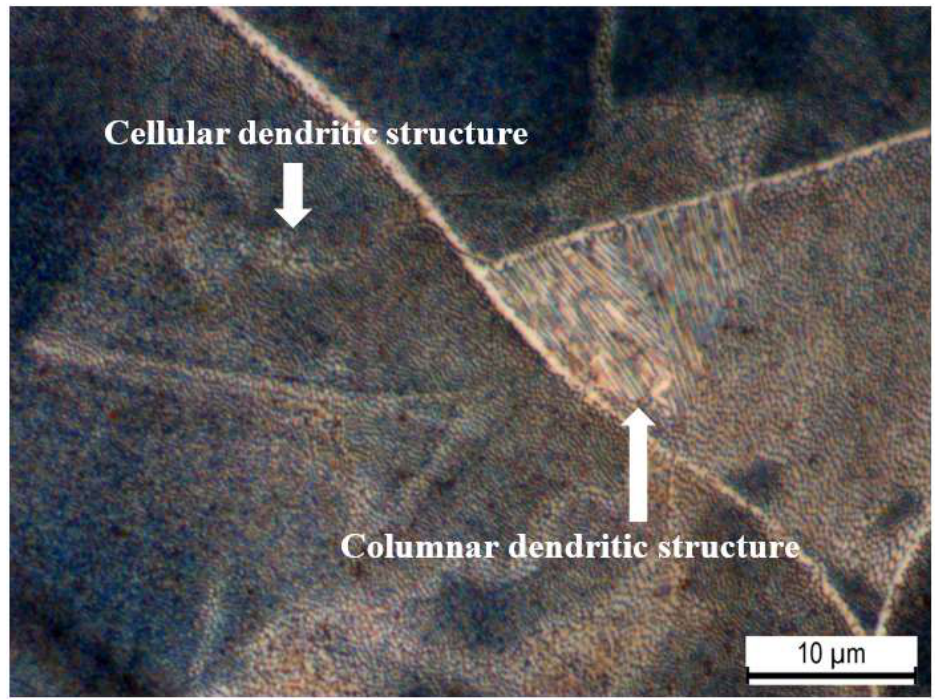
Figure 5. Columnar and cellular dendritic structures in the AP microstructure.